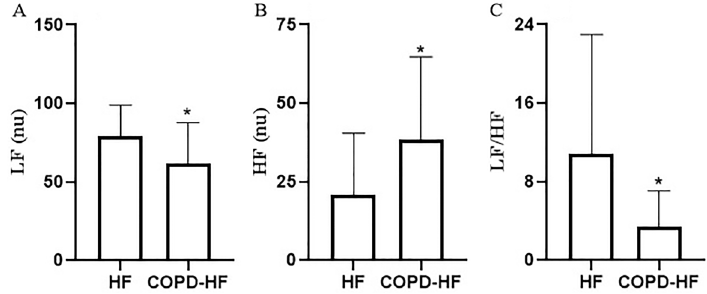
Figure 4. Heart rate variability indices during respiratory sinus arrhythmia maneuver in heart failure (HF) patients and chronic obstructive pulmonary disease-heart failure (COPD-HF) patients. LF: low-frequency band; HF nu: high-frequency band; nu: normalized units; LF/ HF: ratio between LF and HF. Data are reported as means ± SD. *P o 0.05 (Student ’ s t